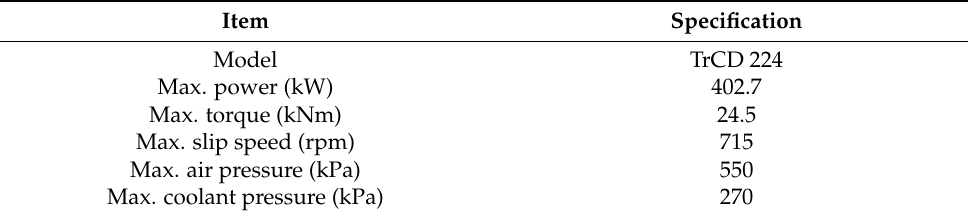
Table 4. Specifications of the axle dynamometer used in this study.